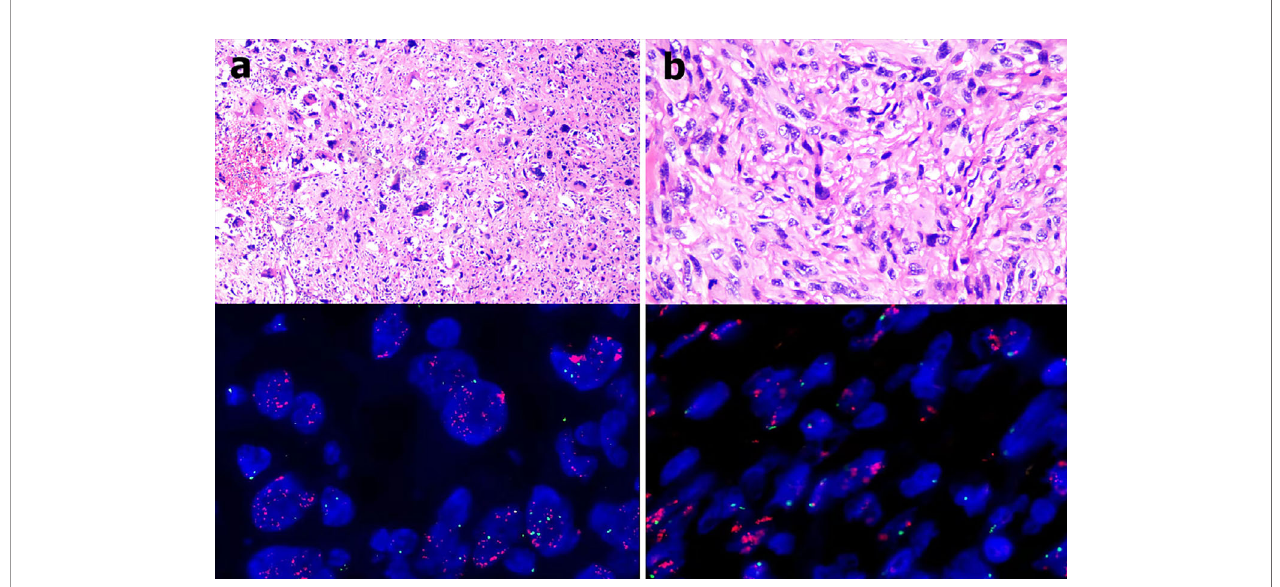
FIGURE 1 | (A) The 2014 pathological examination indicated a pleomorphic liposarcoma (hematoxylin and eosin staining, 400 × magni fi cation) and MDM2 ampli fi cation in tumor tissues as revealed by fl uorescence in situ hybridization (red fl uorescence: MDM2, green fl uorescence: CEP12; mean MDM2 signal: 35.1, mean CEP12 signal: 1.7, MDM2/CEP12 ratio = 20.65). (B) The 2017 pathological examination indicated a de-differentiated liposarcoma (hematoxylin and eosin staining, 400 × magni fi cation) and MDM2 ampli fi cation in tumor tissues as revealed by fl uorescence in situ hybridization (red fl uorescence: MDM2, green fl uorescence: CEP12; mean MDM2 signal: 27.4, mean CEP12 signal: 1.8, MDM2/CEP12 ratio =